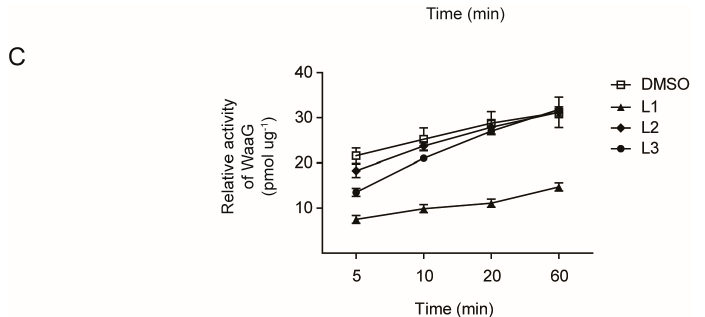
Figure 3. Compound L1 inhibits His-WaaG. ( A ) Structures of ligands: L1, 4-(2-amino-1,3-thiazol-4-yl)phenol; L2, 4-(1H-pyrrol-1-yl)benzoic acid; L3, 2-(1H-pyrrol-1-ylmethyl)pyridine. ( B ) Mixed micelles containing 20 mM CHAPS, 10 mM PG and 1 mM CL were mixed with LPS TRUNC (0.5 µg·mL − 1 ) and UDP-Glc*. The reaction was started by adding His-WaaG (0.1 mg·mL − 1 ) and incubated either with 2.5% DMSO ( v / v ) or 25 mM of compound L1, L2 or L3. Samples were collected after different time points, inactivated by adding Laemmli buffer, separated by SDS-PAGE and detected by autoradiography. ( C ) Quantification of the activity of His-WaaG in the presence of either DMSO or 25 mM L1, L2 or L3. Gels in (B) were quantified by densitometry, and the activity was calculated as described in the Experimental Section.